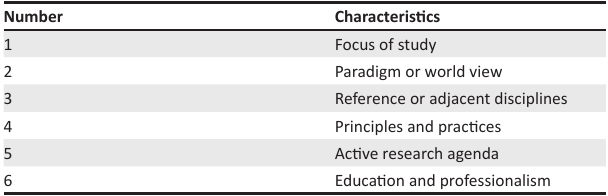
TABLE 1: Characteristics of a